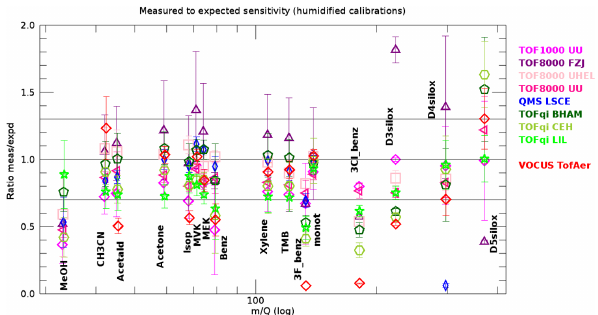
Figure 7. Measured versus expected sensitivities retrieved from hu- midified injections for all compounds in the gas standard and all PTR-MS instruments. The error bars represent the standard devia- tion of all gas standard injections with humidified N 2 or air as car- rier gas. Compounds as in Fig.